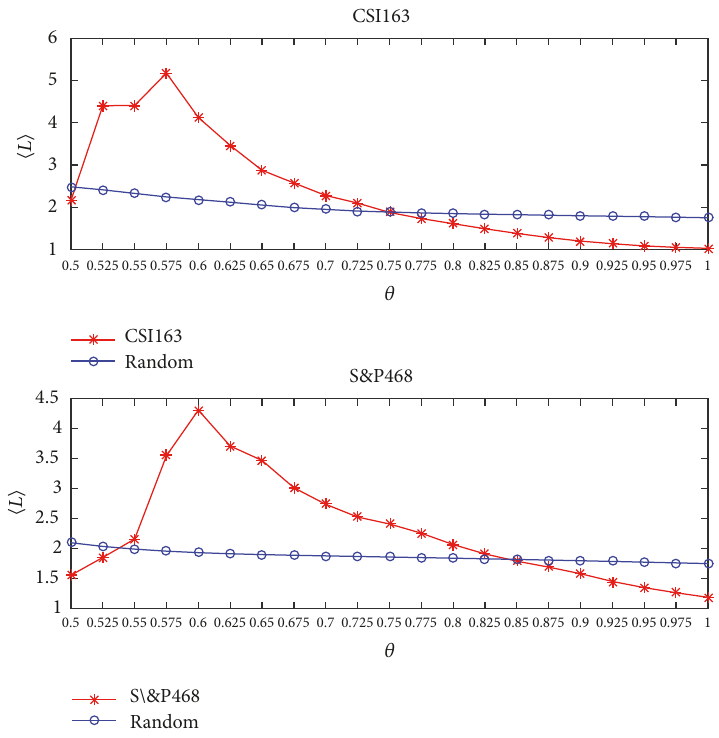
Figure 5: Average path lengths ⟨𝐿⟩ for CSI163 and S&P468 under different 𝜃 compared with values for random networks in same sizes of 163 × 163 and 468 × 468 . It shows that for the two networks, there are peaks of ⟨𝐿⟩ above the curve of the corresponding random networks. At first, 𝜃 is small, most edges are filtered, and the whole networks are broken into parts; thus the disconnected vertices and edges are also filtered. So on the left hand, starting from the peak, with the decrease of 𝜃 , we see that ⟨𝐿⟩ decreases too, while starting from the peak, with the increase of 𝜃 , we see a constant decline of ⟨𝐿⟩ , for more edges remained resulting in decreasing of ⟨𝐿⟩ . For the random networks, ⟨𝐿⟩ stay almost unchanged because of the homogeneous edge distributions across the whole networks.